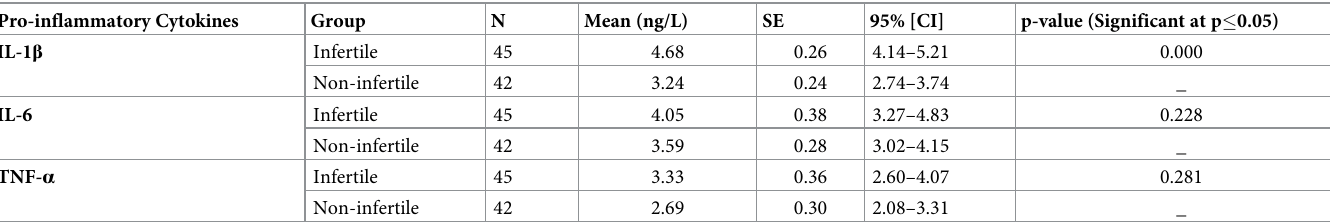
Table 3. Status of Pro-inflammatory cytokines in infertile and non-infertile cohorts. Pro-inflammatory Cytokines